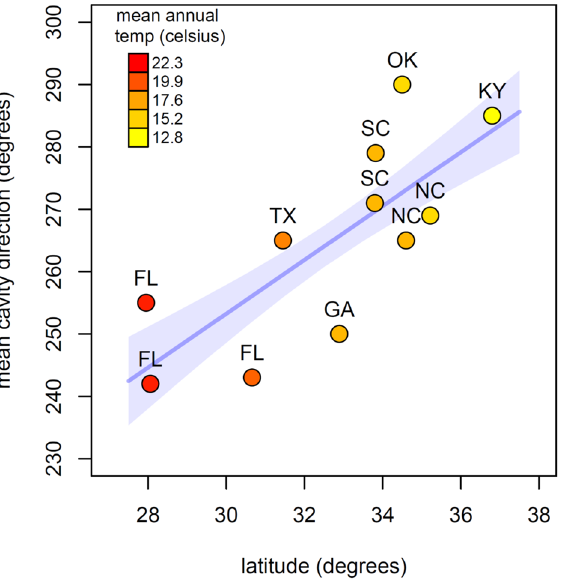
Figure 2. Cavity alignment significantly shifts toward north with increasing latitude (R 2 = 0.588, t = 3.586, p = 0.006) and decreasing temperatures. Blue line and shading show model fit ± 1 SE. Data from studies reported in Table 1. Letters indicate the state in which the population is